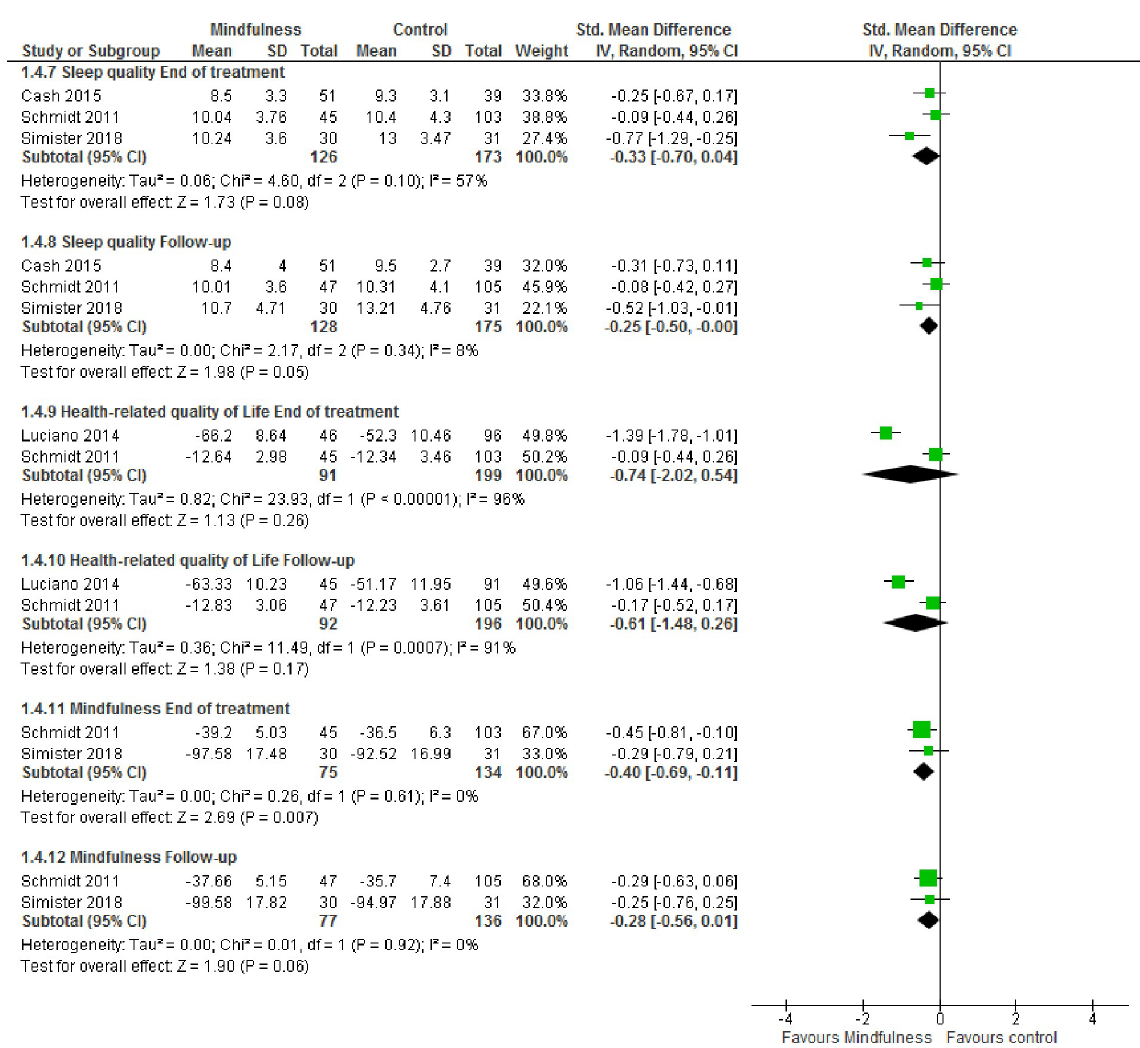
Fig 3. Forest plot for meta-analyses of effects of mindfulness- and acceptance-based interventions. Random-effects meta-analyses of effects of mindfulness- and acceptance-based interventions on sleep quality, health-related quality of life and mindfulness at end of treatment (8-weeks) and follow-up (2–6